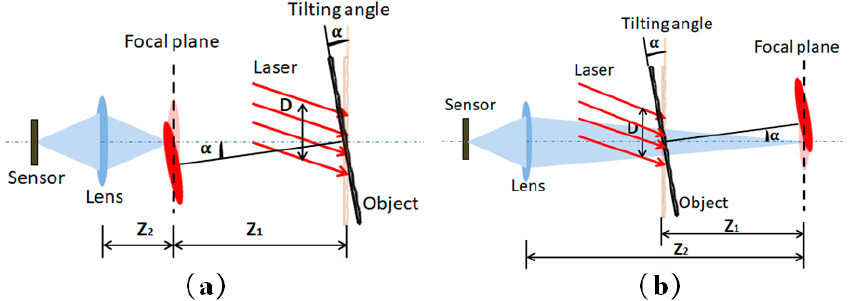
Figure 1. Schematic of the system: camera is focused on the plane ( a ) behind or ( b ) in front of the object.